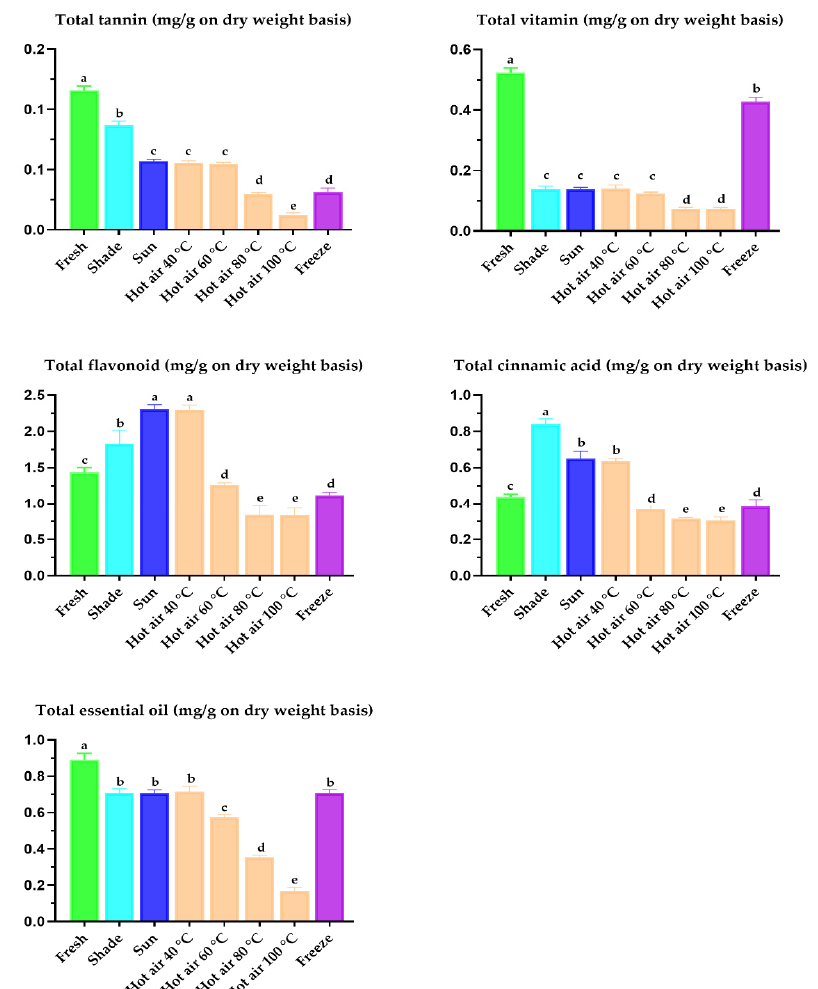
Figure 4. Total tannin, total vitamin, total flavonoid, total cinnamic acid, and total essential oil of dried P. sarmentosum leaves as estimated by using the present developed HPLC method. Data reported as least-squares means ± SEM ( n = 20). a–e A different superscript indicates a significantly different mean ( p < 0.05).